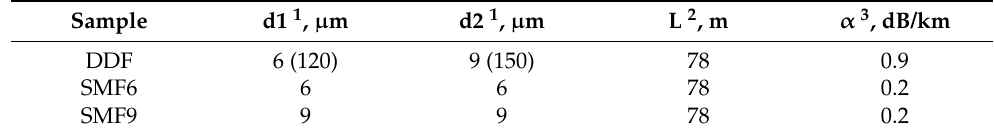
Table 1. Parameters of used NF samples.